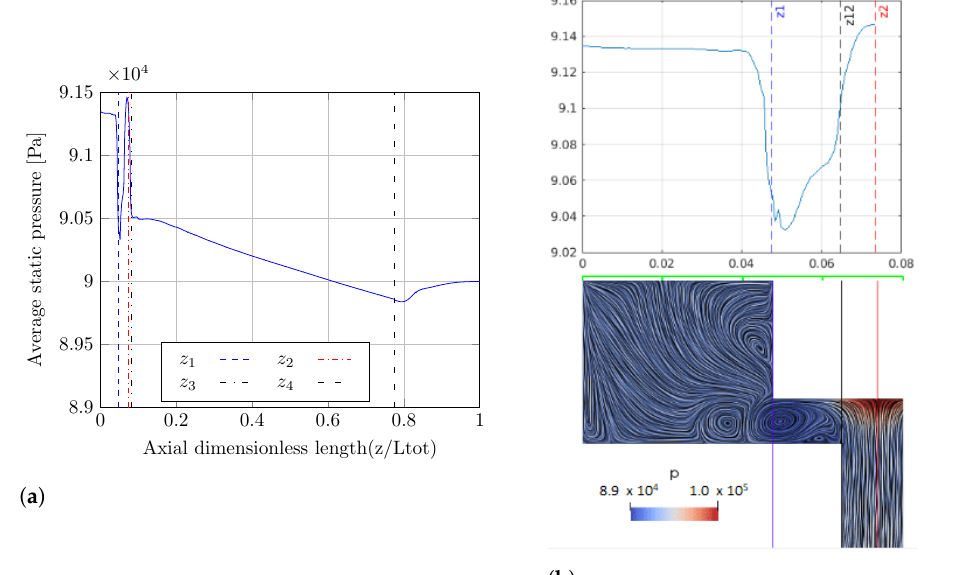
Figure 11. Pressure averaged over section z (constant), plotted against z / L tot ( a ). Velocity streamlines and average pressure in front chamber and jet region ( b